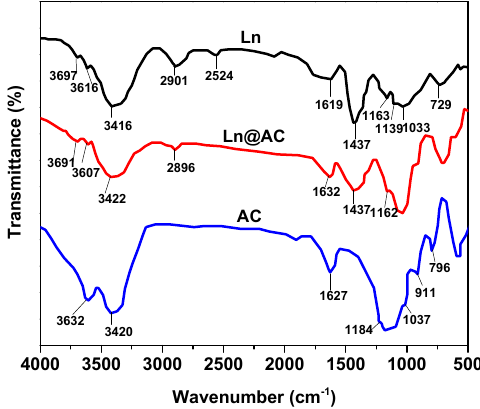
Figure 4. FTIR (Fourier Transform Infrared Spectroscopy) spectra of the Ln, Ln@AC nanocomposite, and AC.